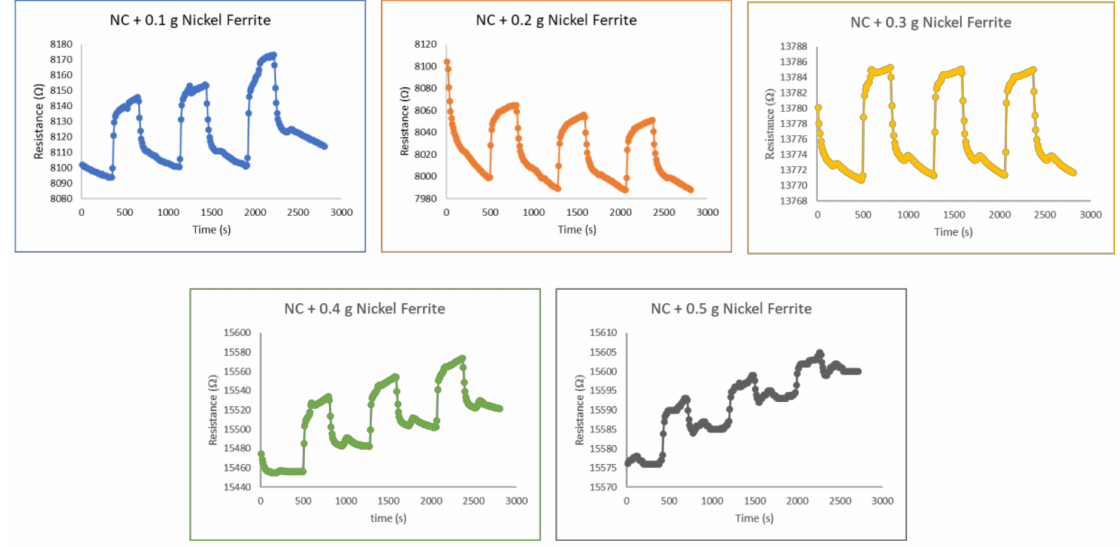
Figure 8. Response of nickel ferrite–nanocellulose nanocomposites to 1% chlorine